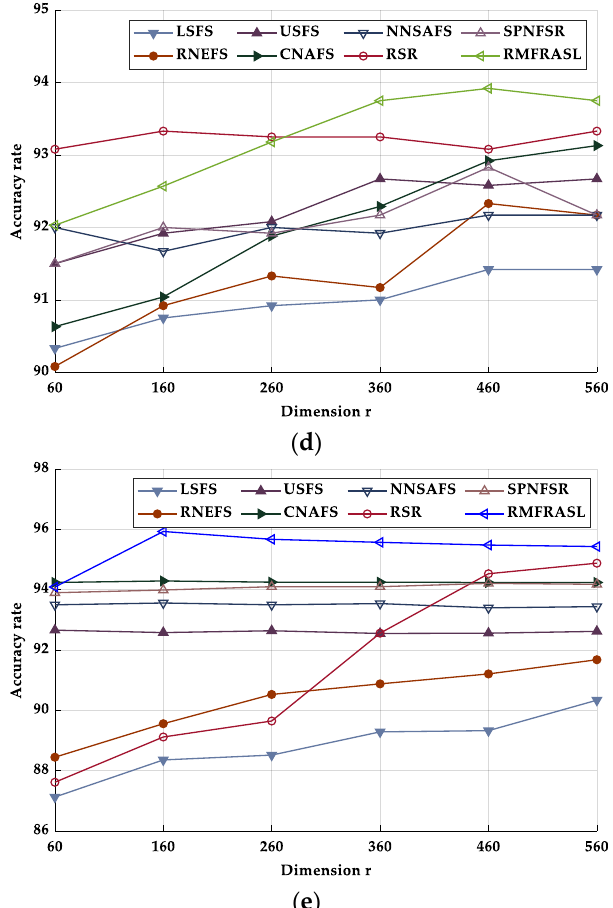
Figure 6. Accuracy rate of each database in different dimensions: ( a ) AR; ( b ) CMU PIE; ( c ) Extended YaleB; ( d ) ORL; ( e ) COIL20.